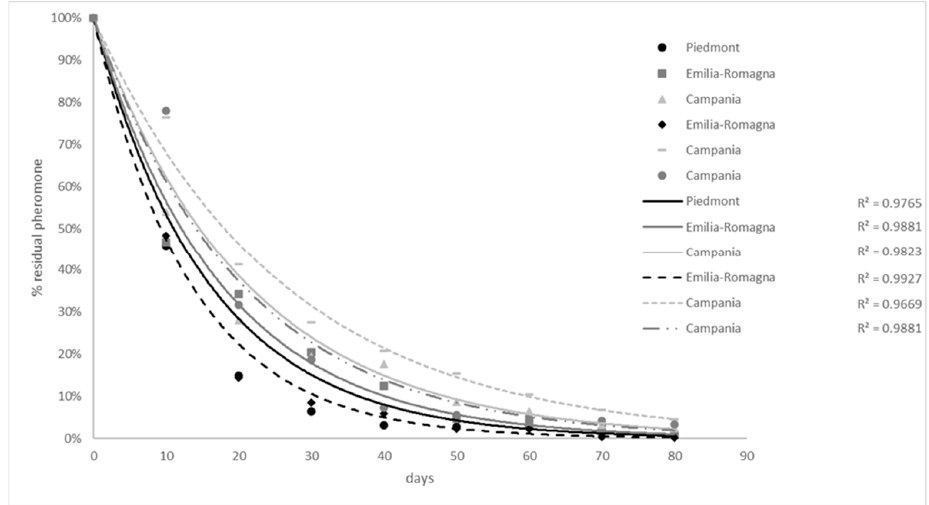
Figure 3 . Release curve of Ecodian ® CT, showing the percentage of residual pheromone tested in Piedmont region (black solid line). The curve is compared to previous data recorded in different sites in Emilia-Romagna (dark grey solid line and black dotted line) and Campania regions (light grey solid line, light dotted line and dark grey dotted line).